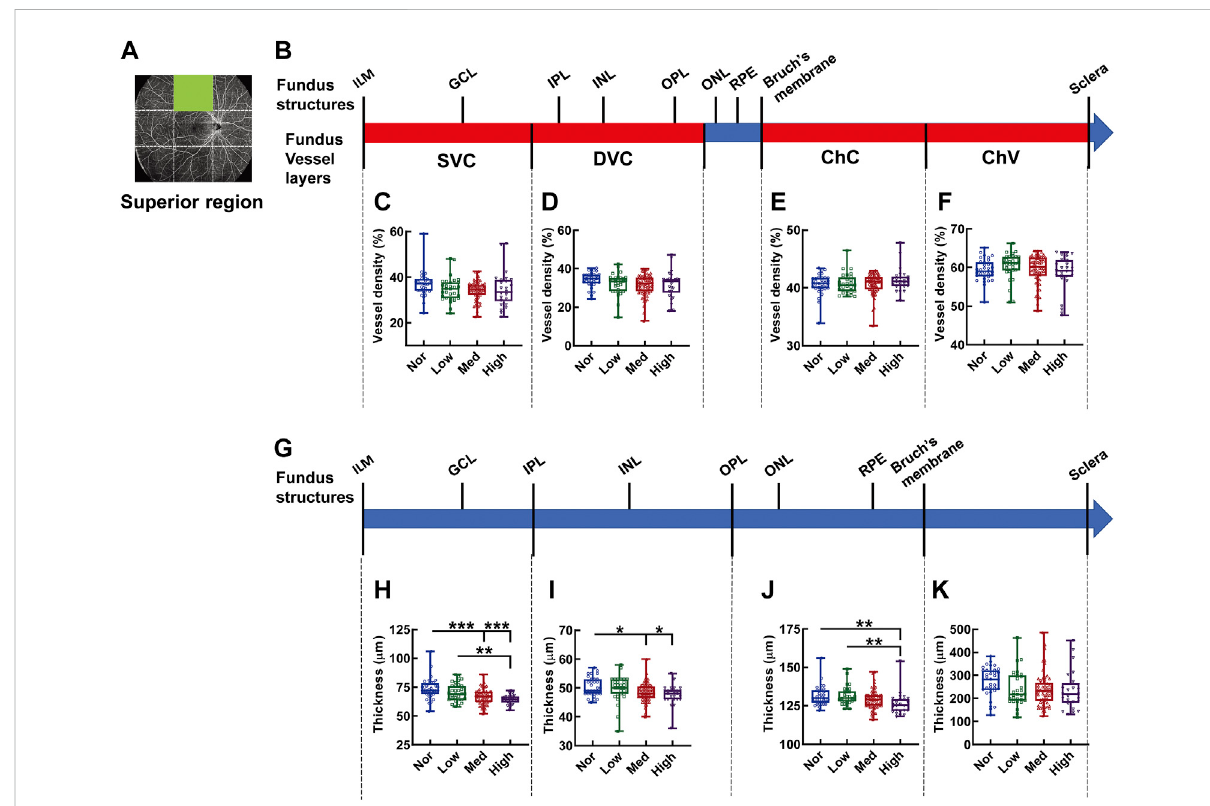
FIGURE 4 Vessel layerdensitiesand structurethicknesses atthesuperiorregionofthefundus. Positionofthesuperiorregionofthefundusisillustrated in (A) .Schematicillustrationofvessellayersinthefundusisshownin (B) .Vesseldensitiesofsuper fi cialvascularcomplex (C) ,deepvascularcomplex (D) , choriocapillary (E) , and choroidal vessel (F) layers are quanti fi ed and compared. Schematic illustration of segments in the fundus is shown in (G) . Thicknesses of the segments from IML to IPL (H) , from IPL to OPL (I) , from OPL to Bruch ’ s membrane (J) , and from Bruch ’ s membrane to the sclera (K) are quanti fi ed and compared. * p < 0.05, ** p < 0.01, *** p < 0.001. SVC, super fi cial vascular complex; DVC, deep vascular complex; ChC, choriocapillary layer; ChV, choroidal vessel layer; NOR, normal group; Low, low-myopia group; Med, medium-myopia group; High, high myopia group; IML, inner limiting membrane; IPL, inner plexiform layer; and OPL, outer plexiform